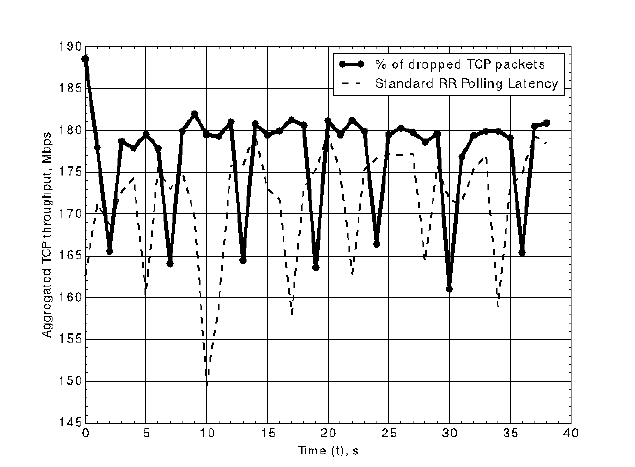
Fig. 10. Performance with different TCP ACKs handling solutions.